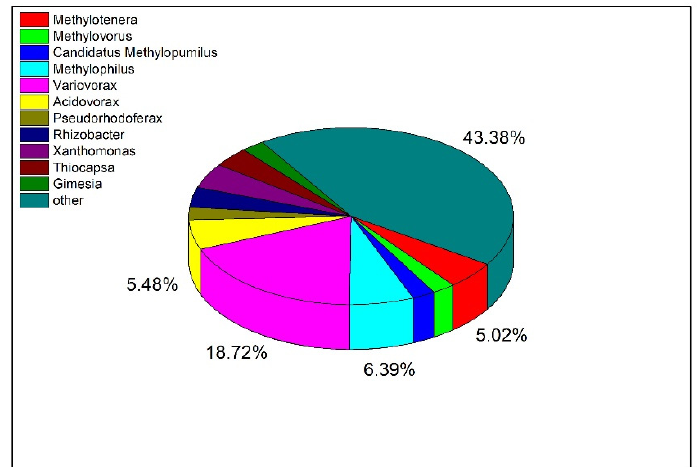
Figure 8. Distribution of Tetrahydroisoquinoline N-methyltransferase in Different Bacteria.